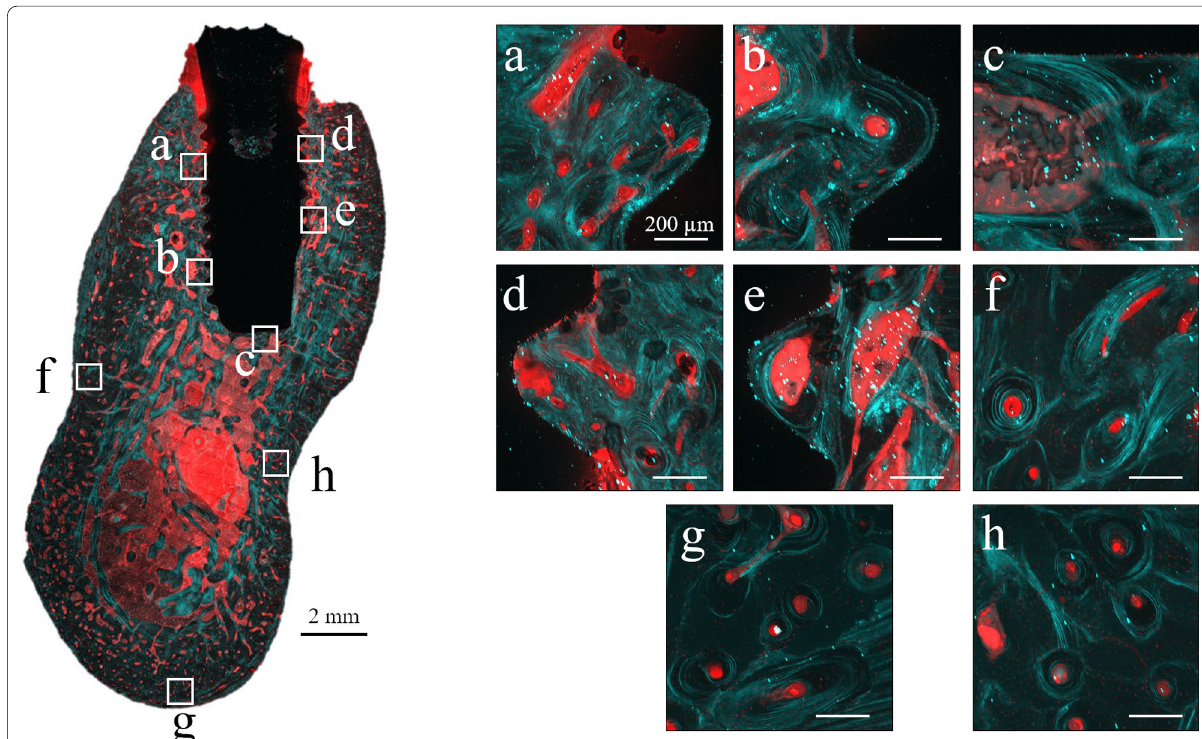
Fig. 3 Analysis of the orientation anisotropy of collagen fibers at each measurement location using SHG imaging. Collagen fibers with thicknesses measuring 345 nm are shown in green, and other structures are indicated in ≥